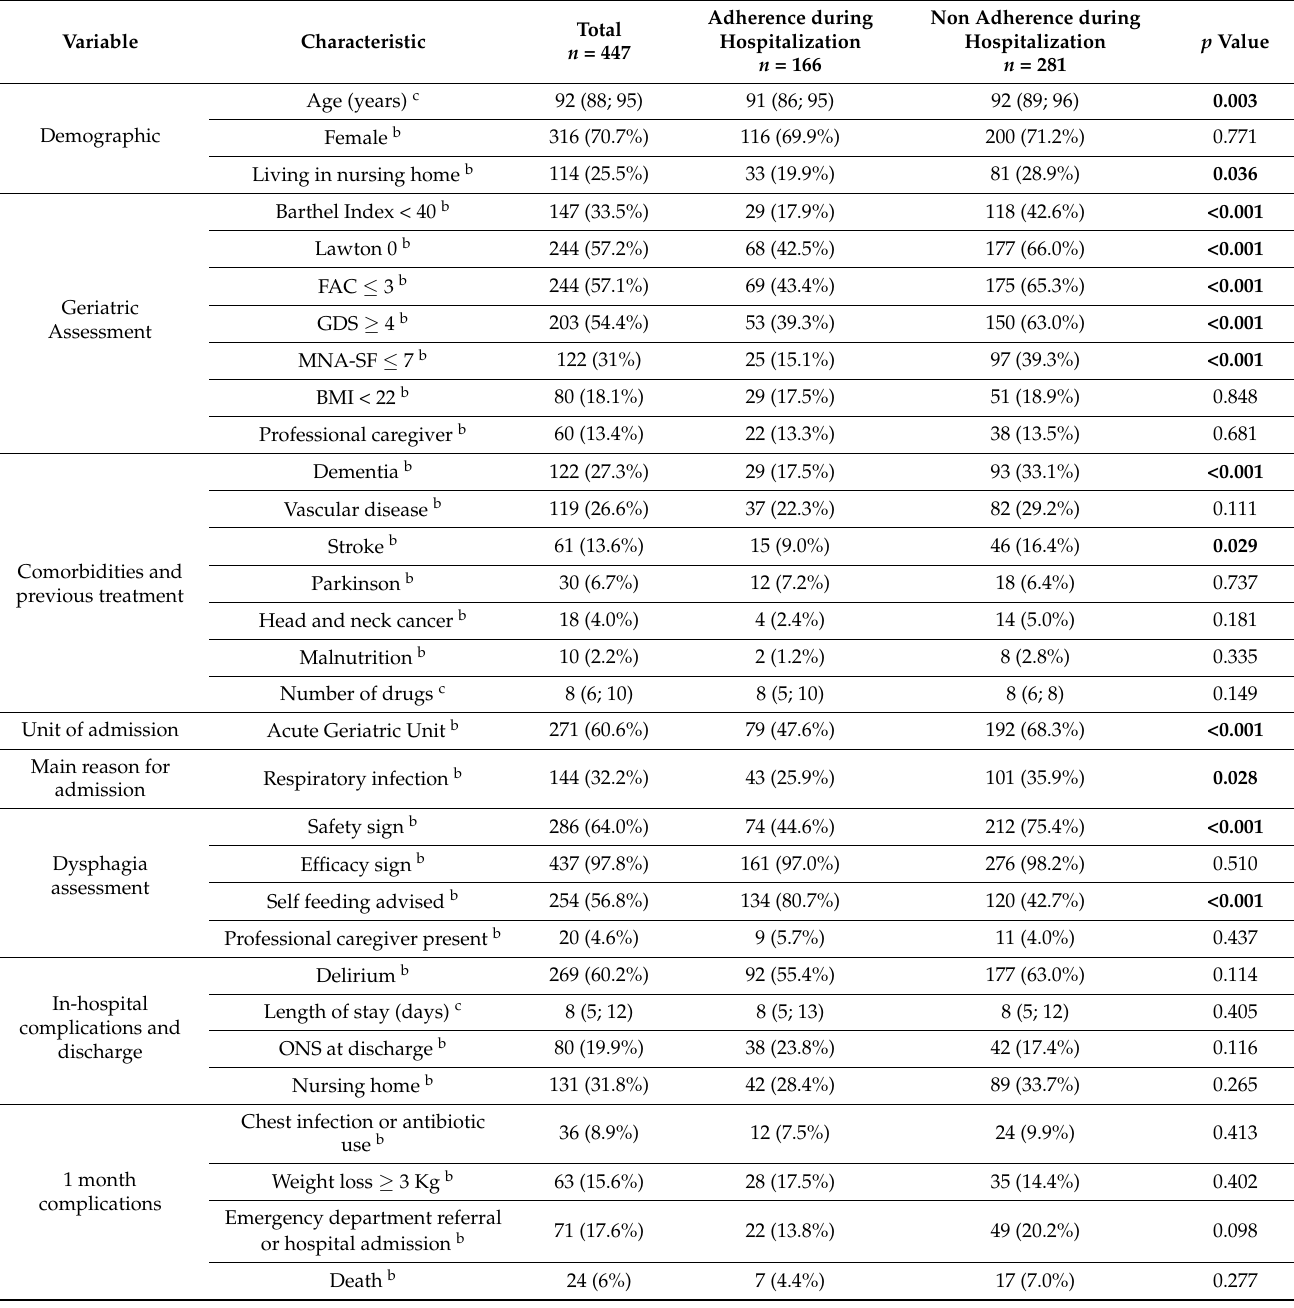
Table 1. Baseline characteristics of patients and factors related to in-hospital adherence a to recom-